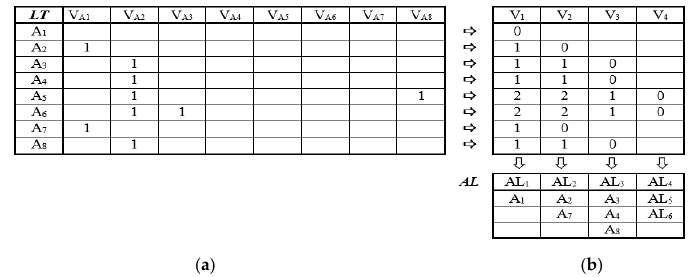
Figure 4. Transposed matrix LT ( a ) and determining the matrix of layers AL ( b ).